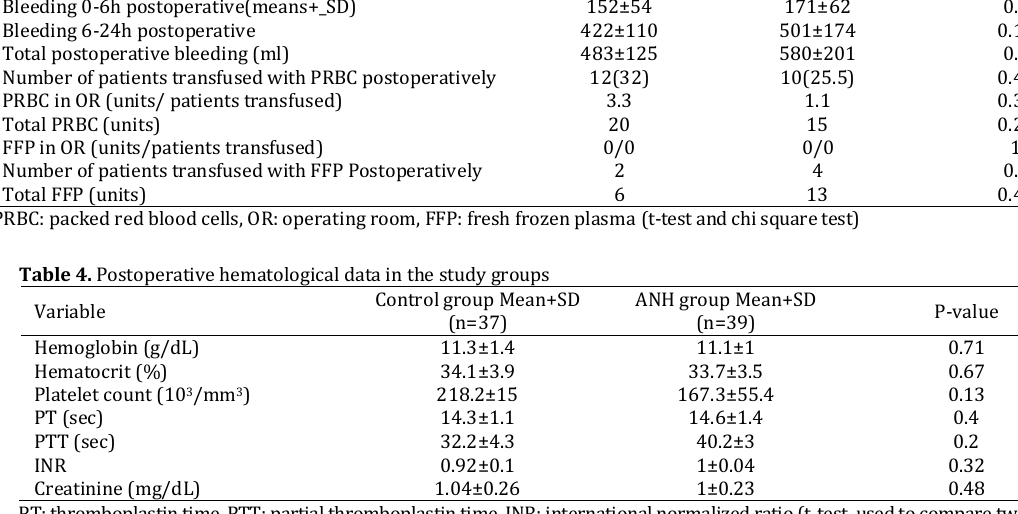
Table 3. Postoperative bleeding and perioperative allogenic transfusion Variable